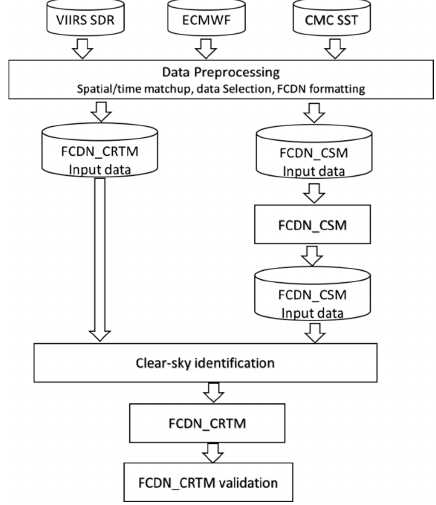
Figure 10. An End-to-End processing chart of FCDN_CRTM System.